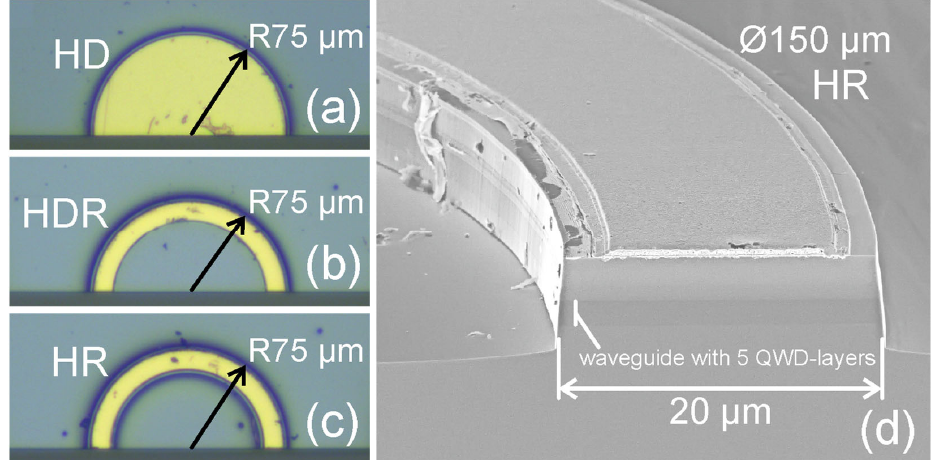
Figure 1. Optical microscopy images of a half ‐ disk with half ‐ round contact (HD, a ), half ‐ disk with half ‐ ring contact (HDR, b ), half ‐ ring with half ‐ ring contact (HR, c ) and scanning electron microscopy image ( d ) of an HR cleaved edge. The diameters of all devices are 150 microns.